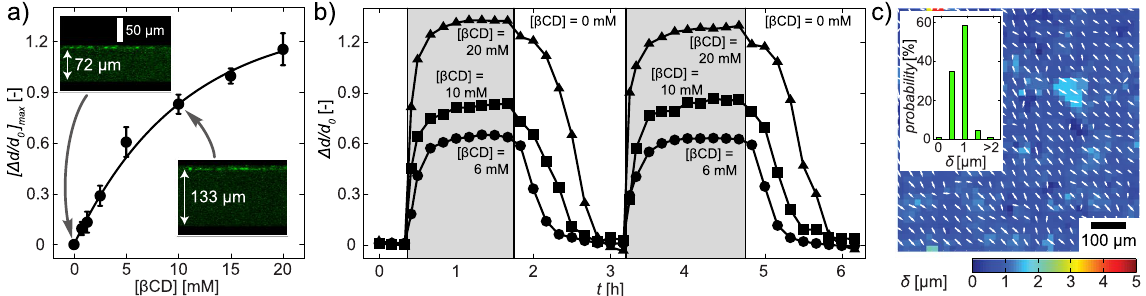
Figure 3. Reversible switching of thickness by medium exchange. ( a ) Maximum swelling ratio [ Δ d / d 0 ] max plotted as a function of β CD concentration. The insets show two representative cross-sectional images of gels at [ β CD] = 0 and 10 mM, reconstructed from the confocal fluorescence microscopy images. Here, fibronectin labeled with HiLyte Fluor ™ 488 was used to confirm the uniform functionalization of gel surfaces. The black line is the fit of the equation β ∝ − − β β f ([ CD]) 1 exp( [ CD]/[ CD] ) (6) with the characteristic concentration [ β CD] c = 10.3 mM. c ( b ) Reversible switching of Δ d / d 0 by repetitive exchanges of media with different β CD concentration; 6 mM ( ● ), 10 mM ( ■ ), and 20 mM ( ▲ ). ( c ) The lateral displacement of fluorescent beads embedded in the gel caused by the incubation with 10 mM β CD for 40 min. The magnitude of displacement is indicated by the color code, while the direction is indicated by the arrows. The histogram in the inset represents the distribution of displacements, implying that the lateral displacement is ≤ 1 µ m for more than 90% of the